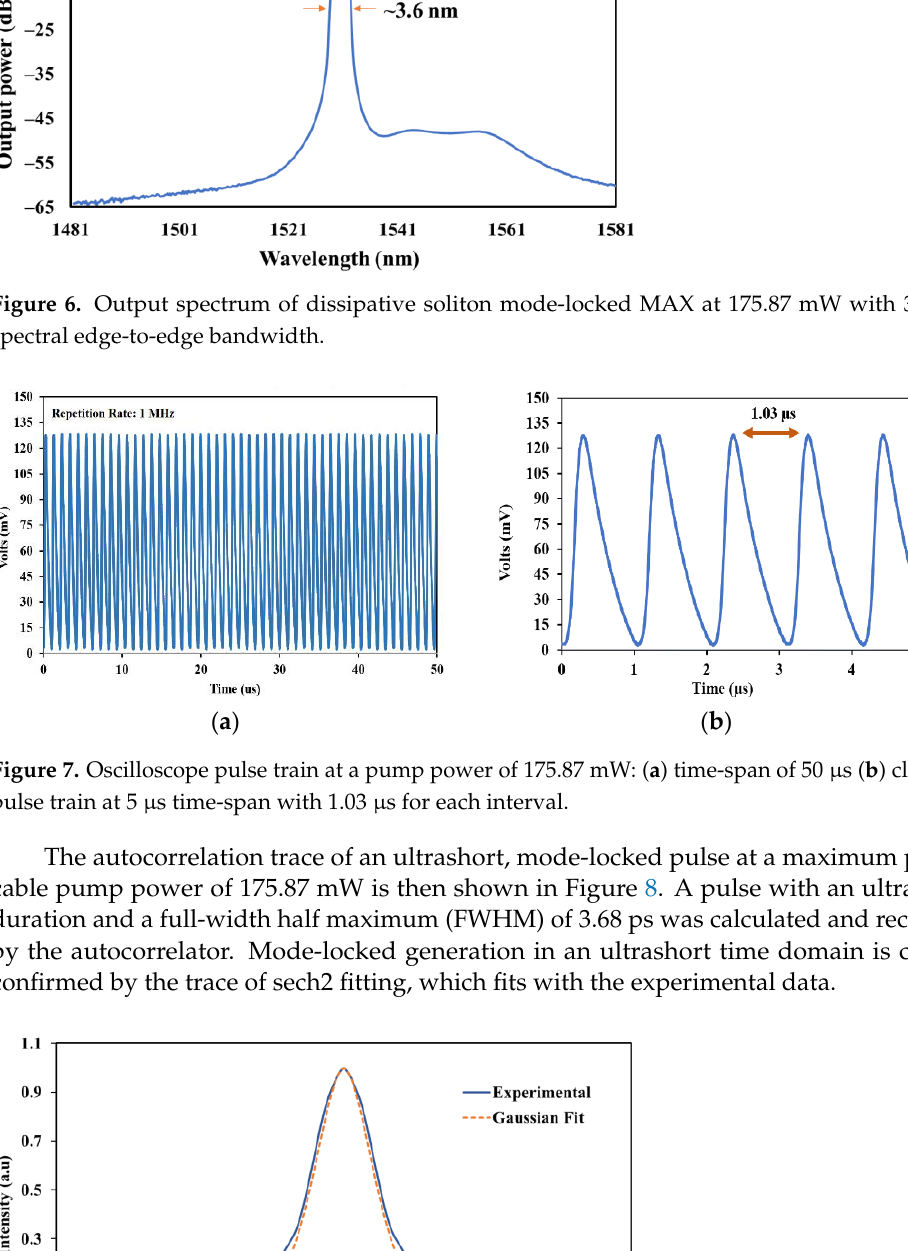
Figure 6. Output spectrum of dissipative soliton mode-locked MAX at 175.87 mW with 3.6 nm spectral edge-to-edge bandwidth.